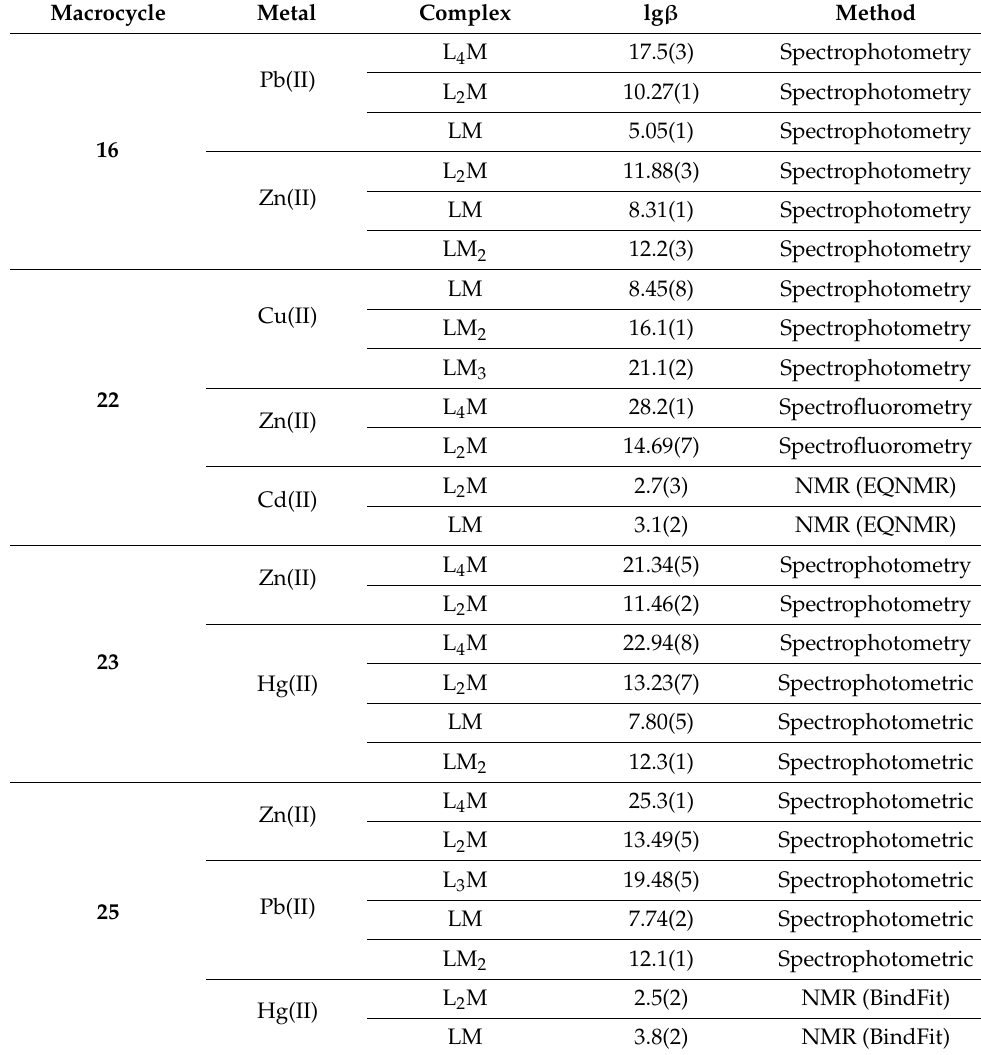
Table 2. Composition and binding constants for selected complexes of the macrocycles 16 , 22 , 23 and 25 .